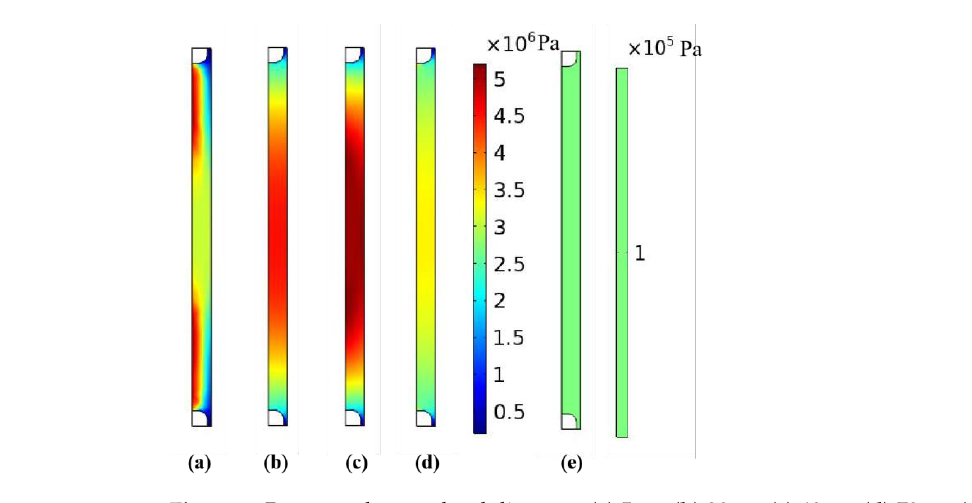
Figure 5. Simulation curve of pressure change.